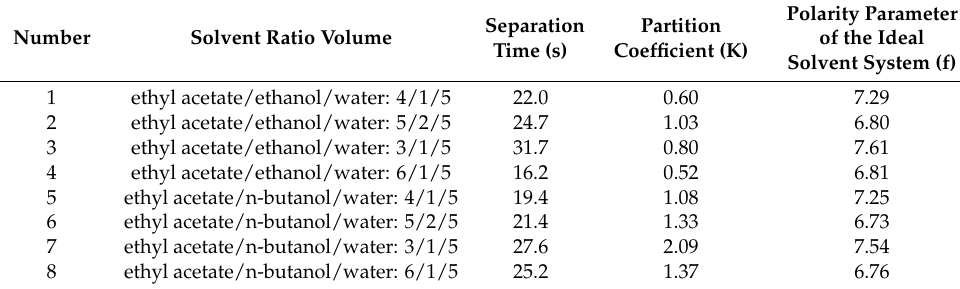
Table 1. Separation performance of solvent systems.